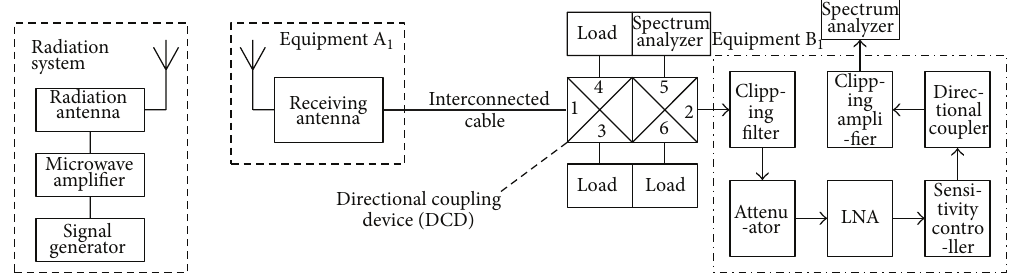
Figure 12: The configuration diagram for the radiation test.